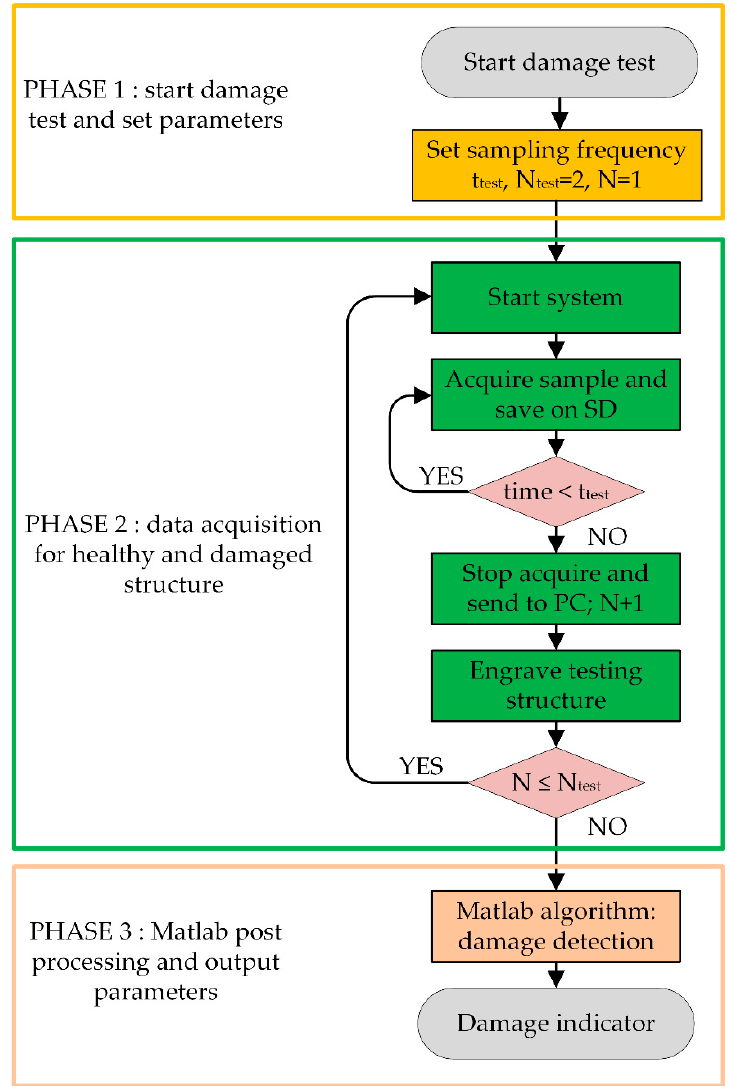
Figure 1. Damage indicator test operating phases.